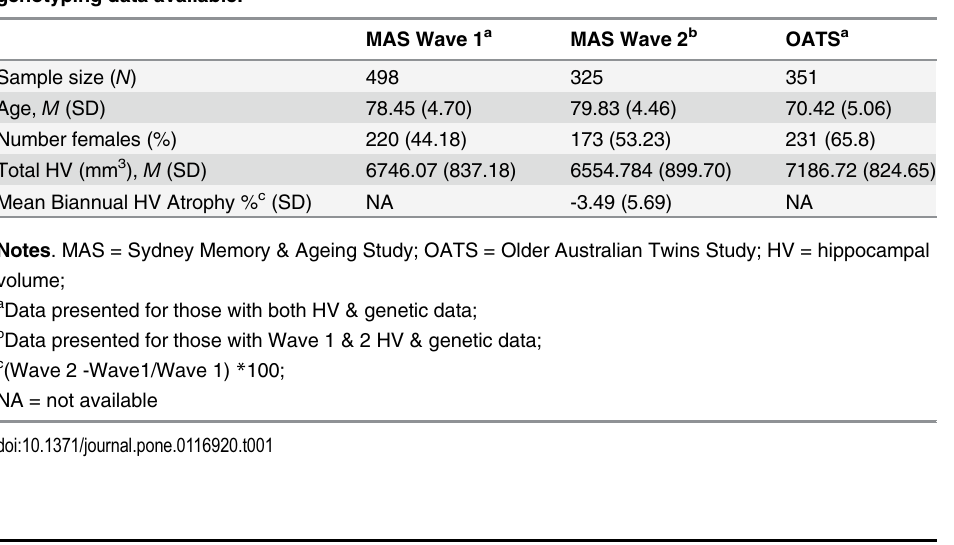
Table 1. Descriptive statistics for Sydney MAS and OATS participants with hippocampal volume and genotyping data